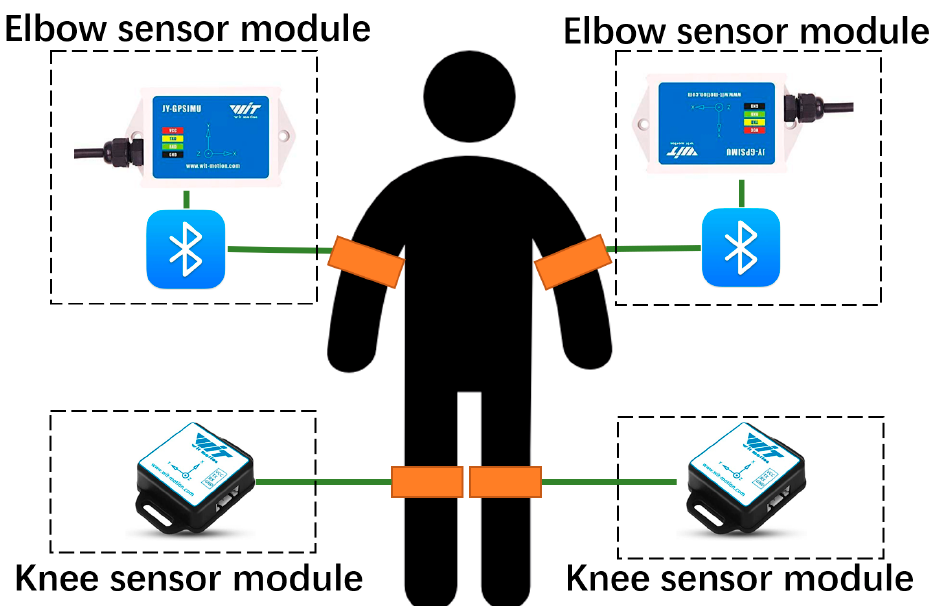
Figure 5. IMU sensor